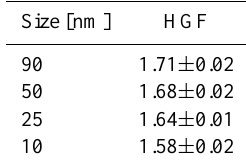
Table 1. Hygroscopic growth factors of ammonium sulphate deter- mined in H-TDMA